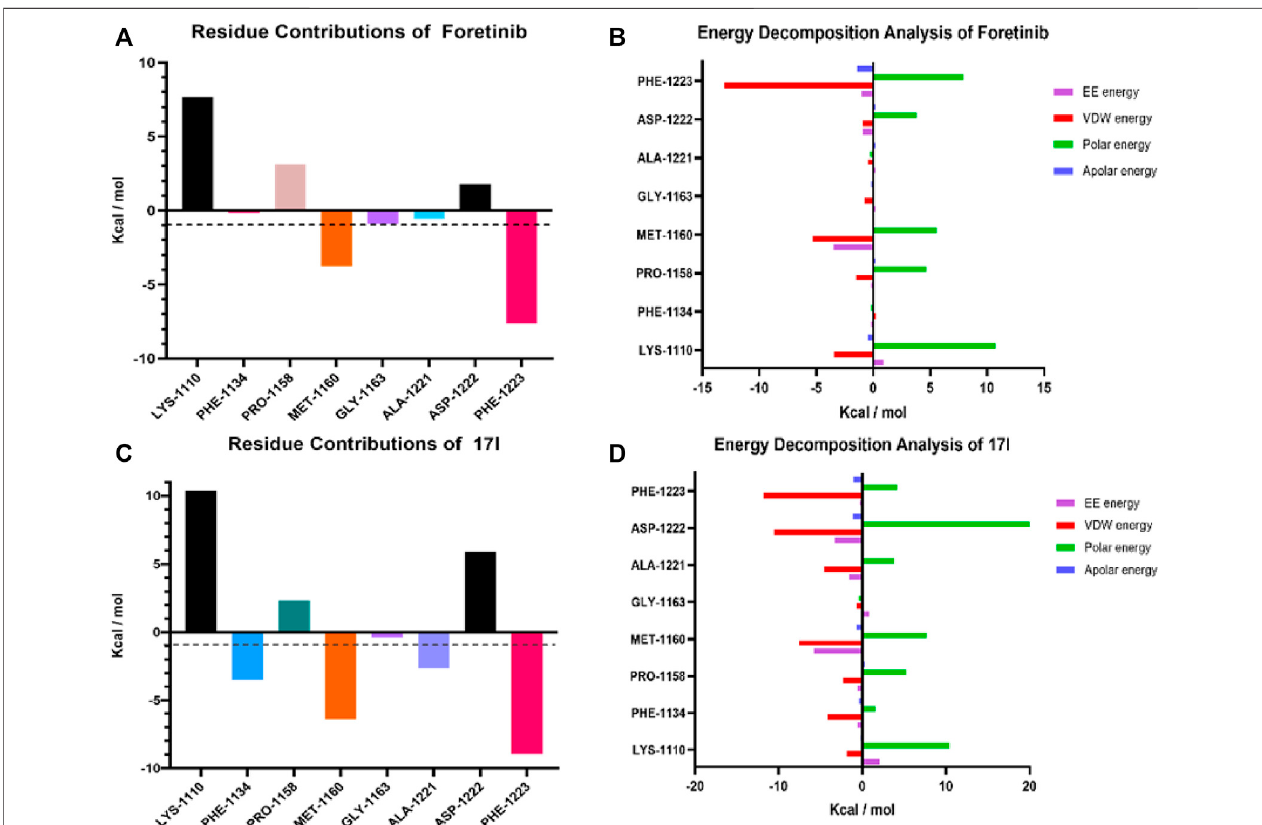
FIGURE 11 | Molecule dynamic stimulation results of foretinib-3LQ8 and 17l – 3LQ8. Residue contributions of potential hot residues of (A) and (C) . Energy decomposition of potential hot residues of (B) and (D) . The unit of energy is kcal/mol.